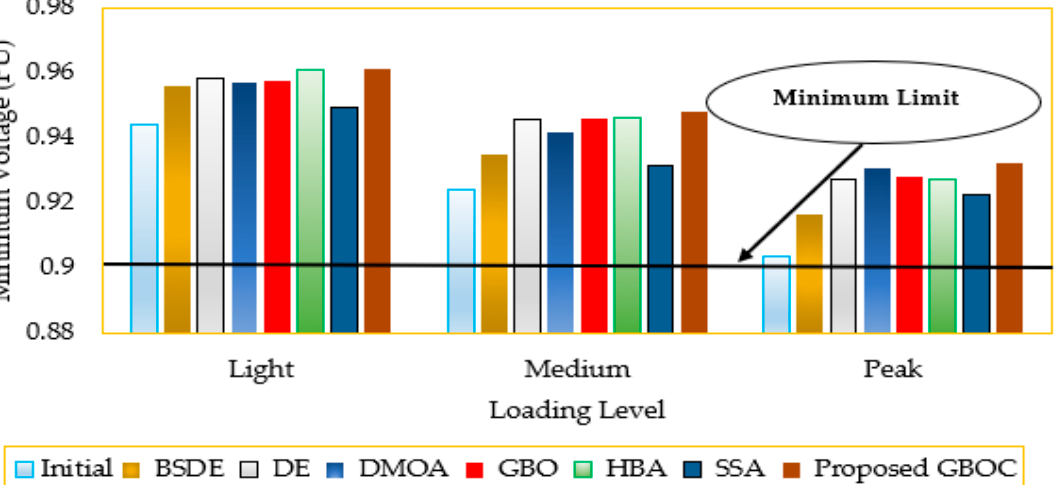
Figure 8. Minimum voltages for the IEEE 33-distribution system of the GBOC versus GBO, SSA, DMOA, DE, and HBA for Scenario 2.